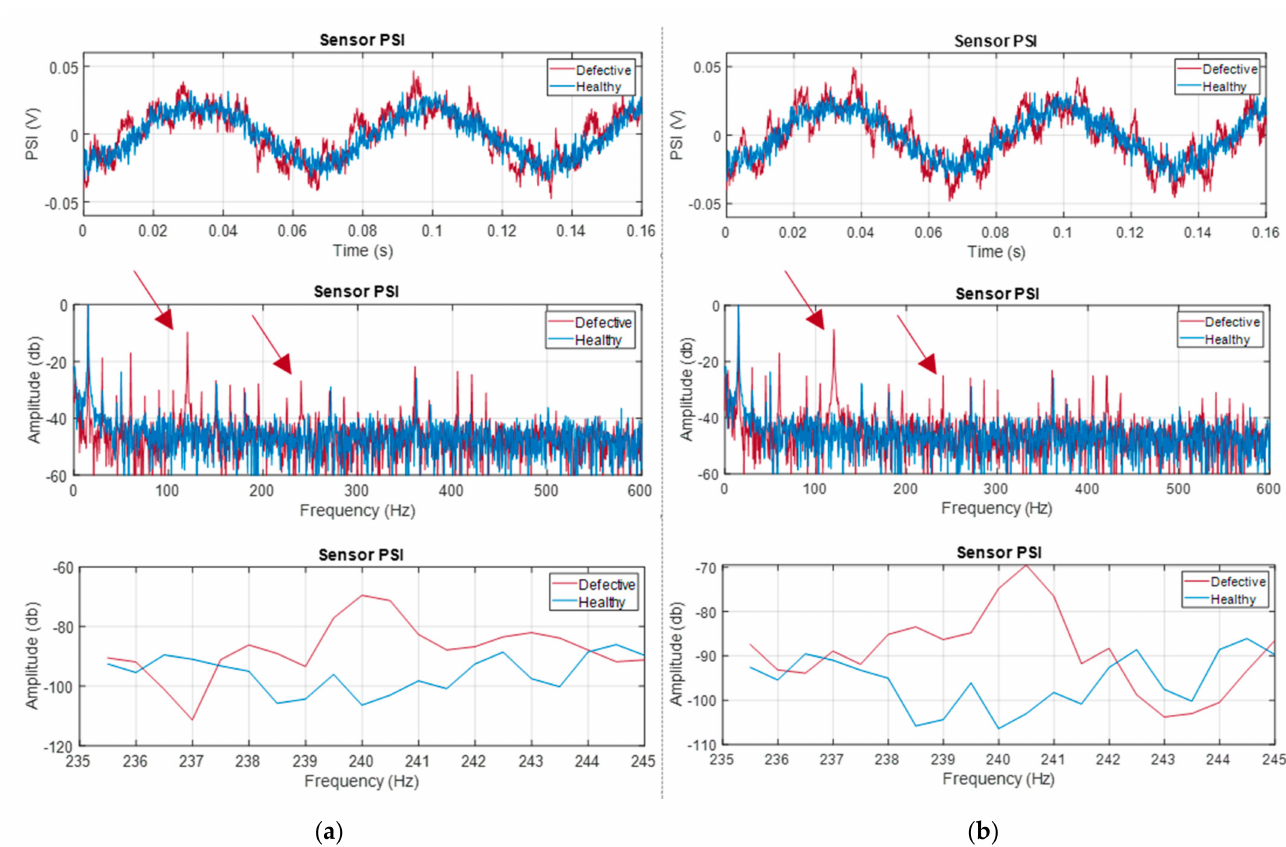
Figure 23. Experimental Investigation of position sensors A and C breakdown fault at permanent ( a ) high state and ( b ) low state for motor operation at 900 rpm and no-load operation using piezoelectric sensor. From top to bottom: Waveform of piezoelectric sensor PSI output, Frequency spectrum and Narrow frequency spectrum using Goertzel